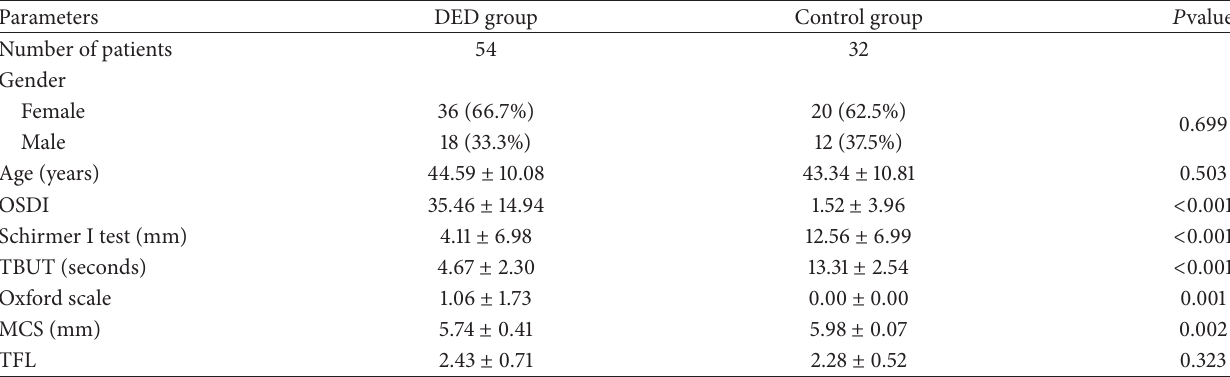
Table 1: Demographic and clinical test results.